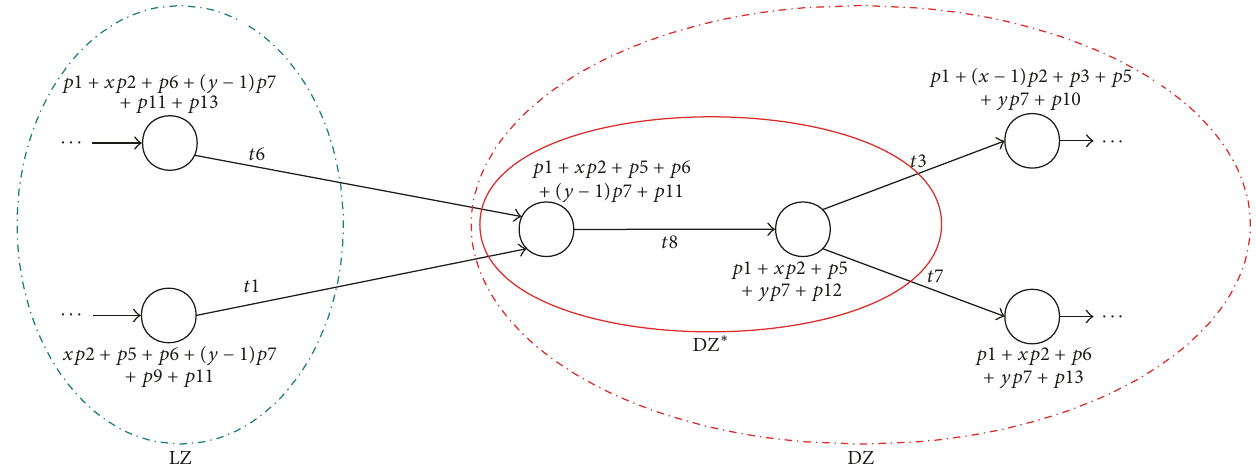
Figure 5: Simulation results in Figure 3 in the case of 𝑀 0 (𝑝 10 ) = 𝑥 and 𝑀 0 (𝑝 11 ) = 𝑦